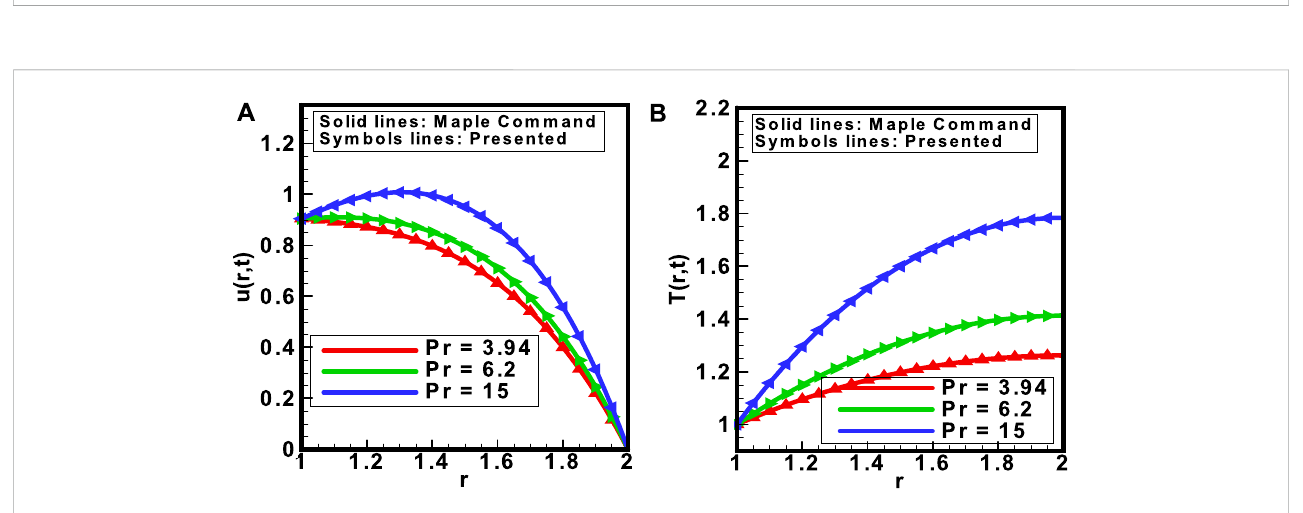
Figure 5 depicts the results for the most important physical parameter: the volumetric fraction ϕ of nanoparticles in base fl uid. The addition of nanoparticles to base fl uid reduces the velocity pro fi le u ( r,t ) within the coaxial cylinder. Therefore, the results were plotted for a range of values ( ϕ (cid:2) 0 , 0 . 1 , 0 . 2 ) , considering different values of the fractional-order parameter α . Addition of nanoparticles to base fl uid increases intermolecular forces and collision of molecules increase, thereby decreasing the velocity pro fi le u ( r, t ) . Figure 6 is a graphical representation of the maximum velocity term E, indicating that velocity reaches its maximum value of E near the boundary of the inner cylinder; on the other hand, it is at its lowest degree at the boundary of the outer cylinder. This graph indicates that, for the lowest value of r and maximum of value of E , u ( r,t ) increases in value. The term ω is the frequency of inner cylinder velocity, and Figure 7 depicts the graphical results for a range of values, such as ( ω (cid:2) 0 , π / 4 , π / 2 ) . For the interval [ 0 , π / 4 ] , due to the cosine function,